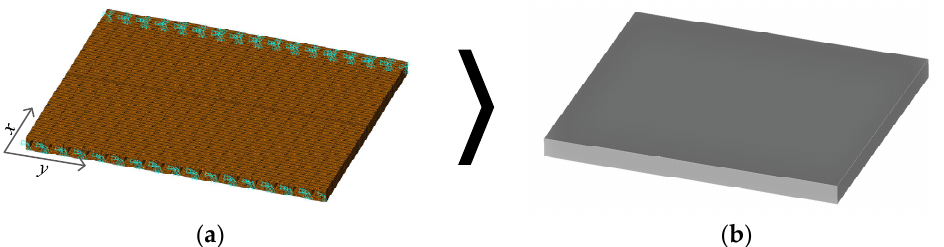
Figure 4. The model of a hollow slab bridge: ( a ) finite element model ; ( b ) equivalent orthotropic plate model.